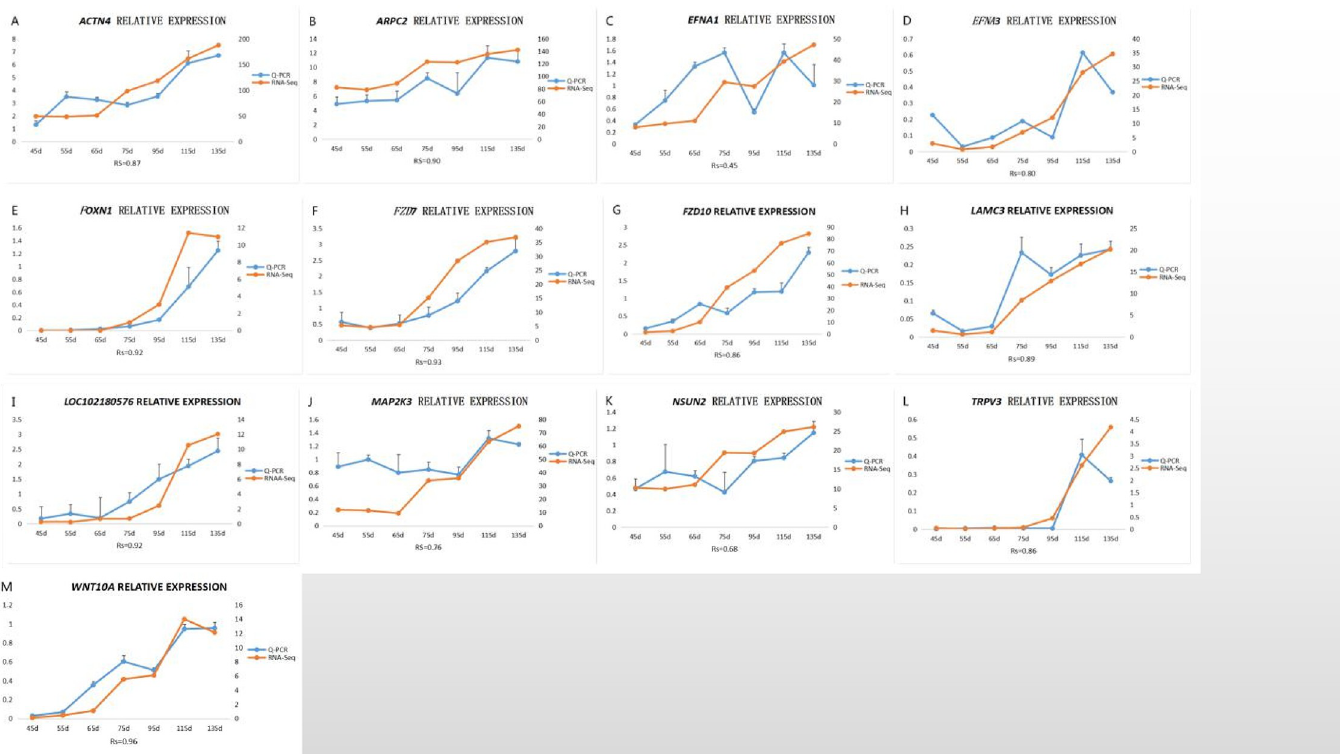
Fig 13. Fluorescent QPCR to verify the sequencing results. Spearman’s rank correlation: 0.8 < |Rs| < 1 extremely strong correlation, 0.6 < |Rs| < 0.8 strong correlation, 0.4 < |Rs| < 0.6 medium correlation, 0.2 < |Rs| < 0.4 weak correlation, 0 < |Rs| < 0.2 no correlation.